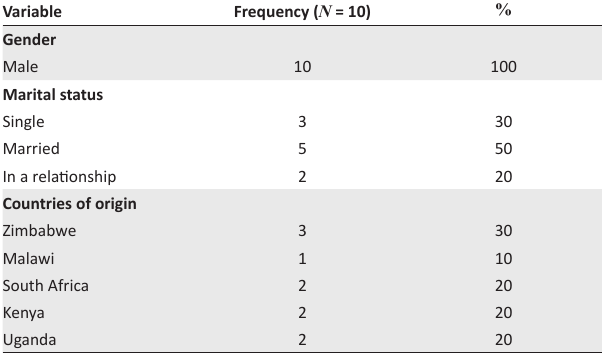
TABLE 1: Key informants’